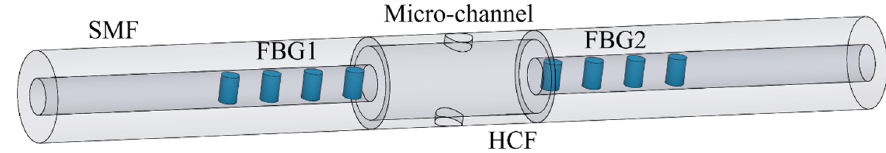
Figure 11. Schematic diagram of the PS-FBG, modulated by a hollow cavity.